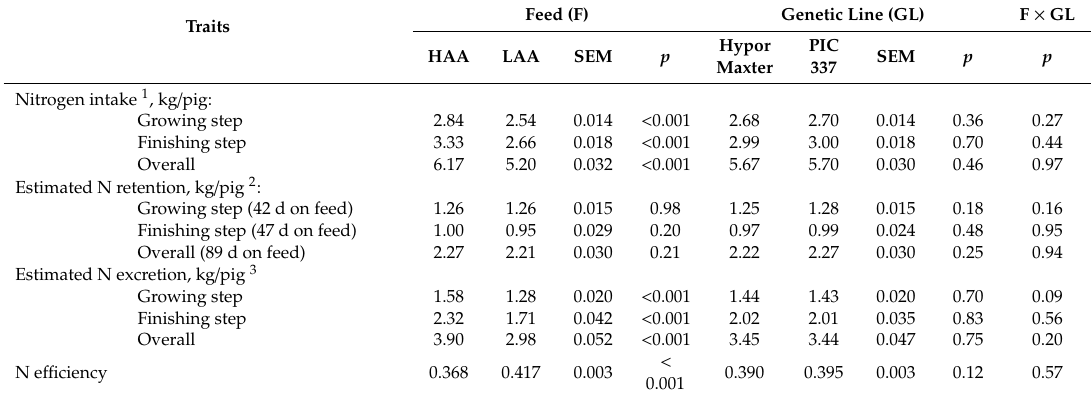
Table 4. Estimated N flow of barrows of two genetic lines fed high (HP) or low (LP) indispensable amino acids